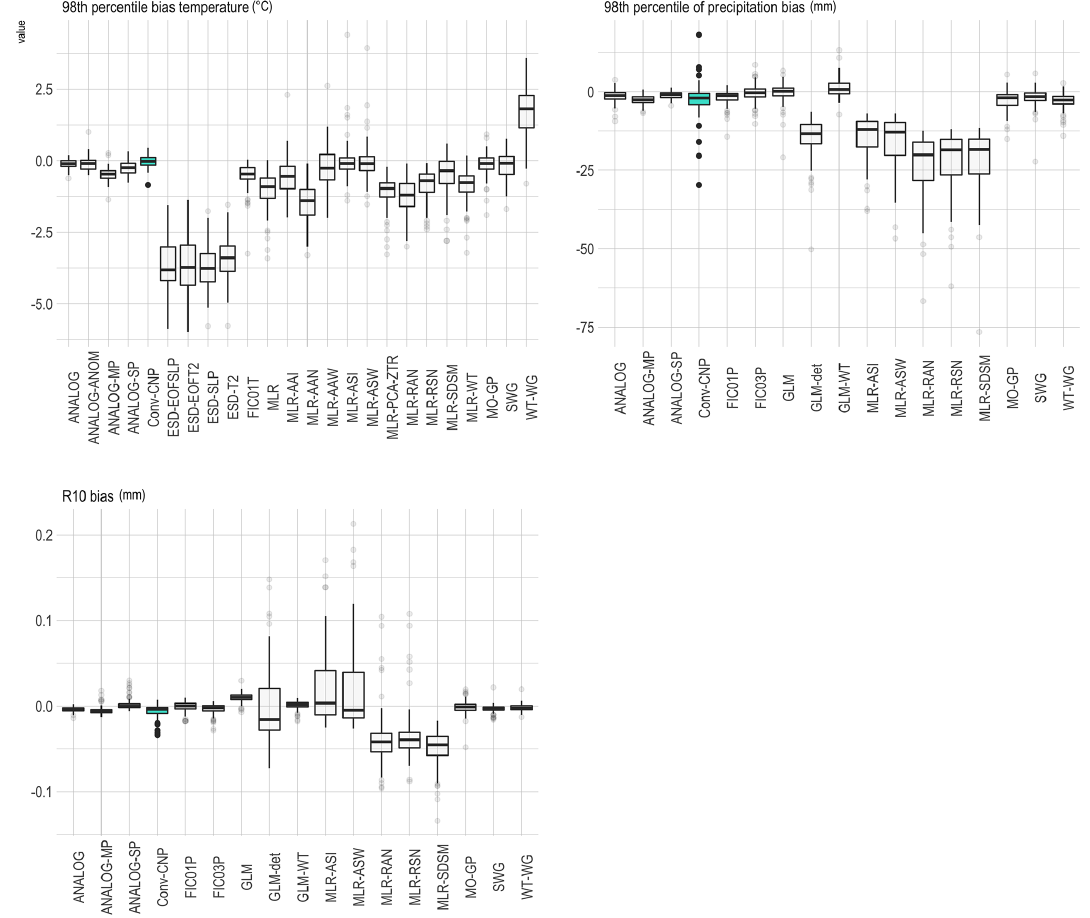
Figure 5. The same as Fig. 4 but for extreme